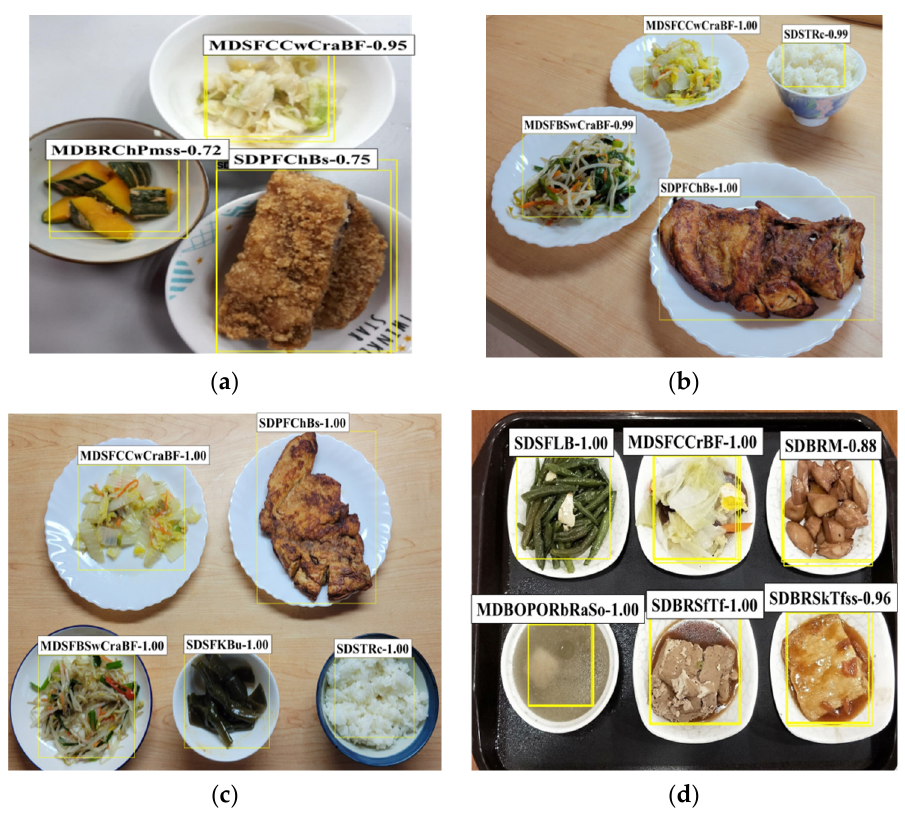
Figure 11. Recognition results for multiple dishes with different number of dishes (T): ( a ) T = 3, ( b ) T = 4; ( c ) T = 5; ( d ) T = 6.